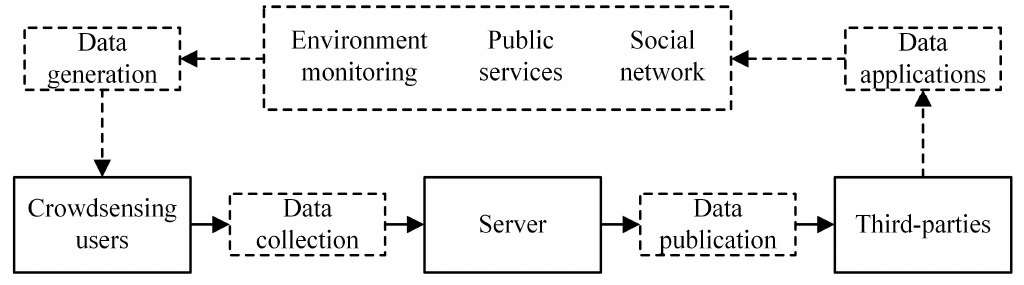
Figure 1. Crowd-Sensing. Figure 1.